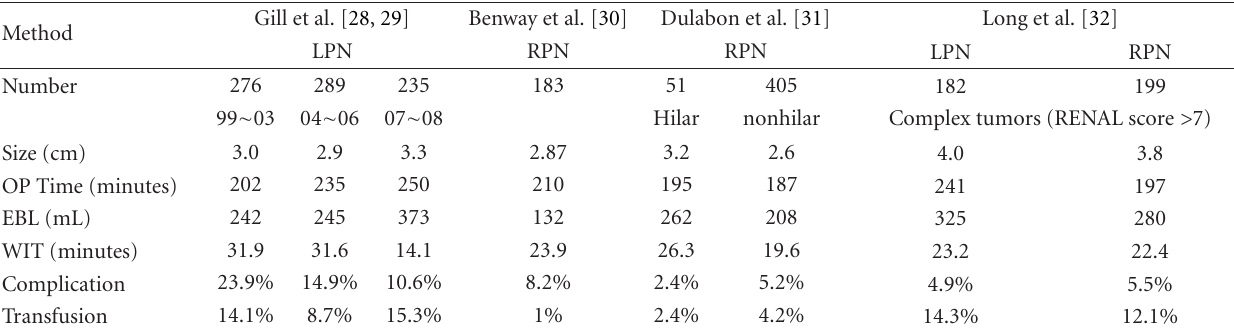
Table 2: Main series of minimal invasive partial nephrectomy (laparoscopic or/and robot assisted laparoscopic method).